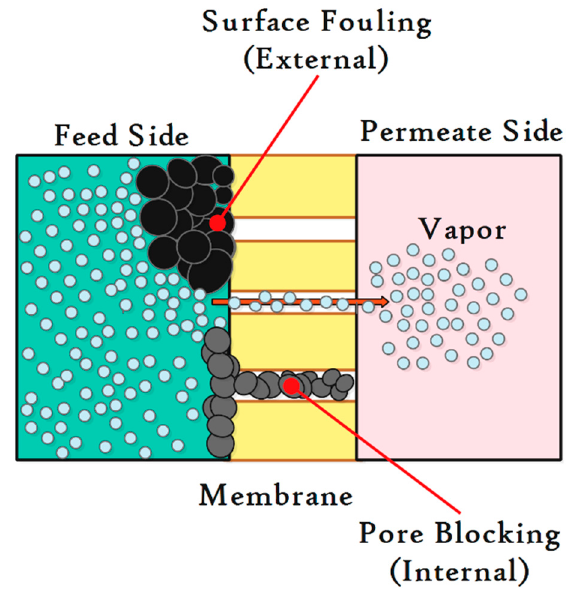
Figure 9. Schematic diagram of surface fouling (external) and pore blocking (internal) [35] .